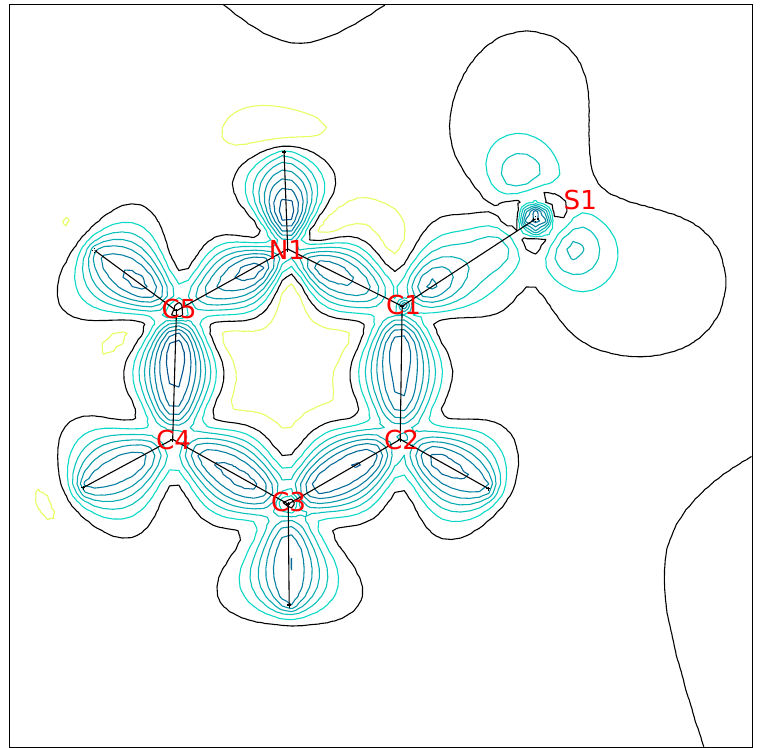
Figure 8. Static deformation density in (I) from the final multipole refinement. Contour level 0.1 e/Å 3 .